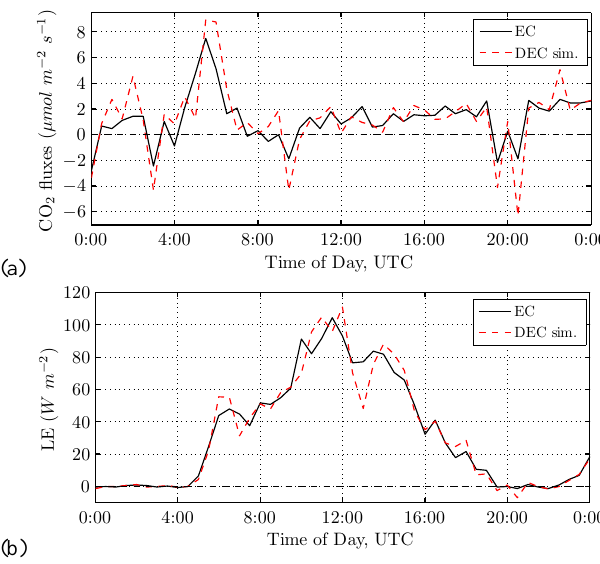
Fig. 7. (a) Diurnal course of CO 2 flux (µmolm − 2 s − 1 ) and (b) la- tent heat flux (Wm − 2 ) measured on 15 June by eddy covariance (solid line) and simulated disjunct eddy covariance (red dashed line) methods.